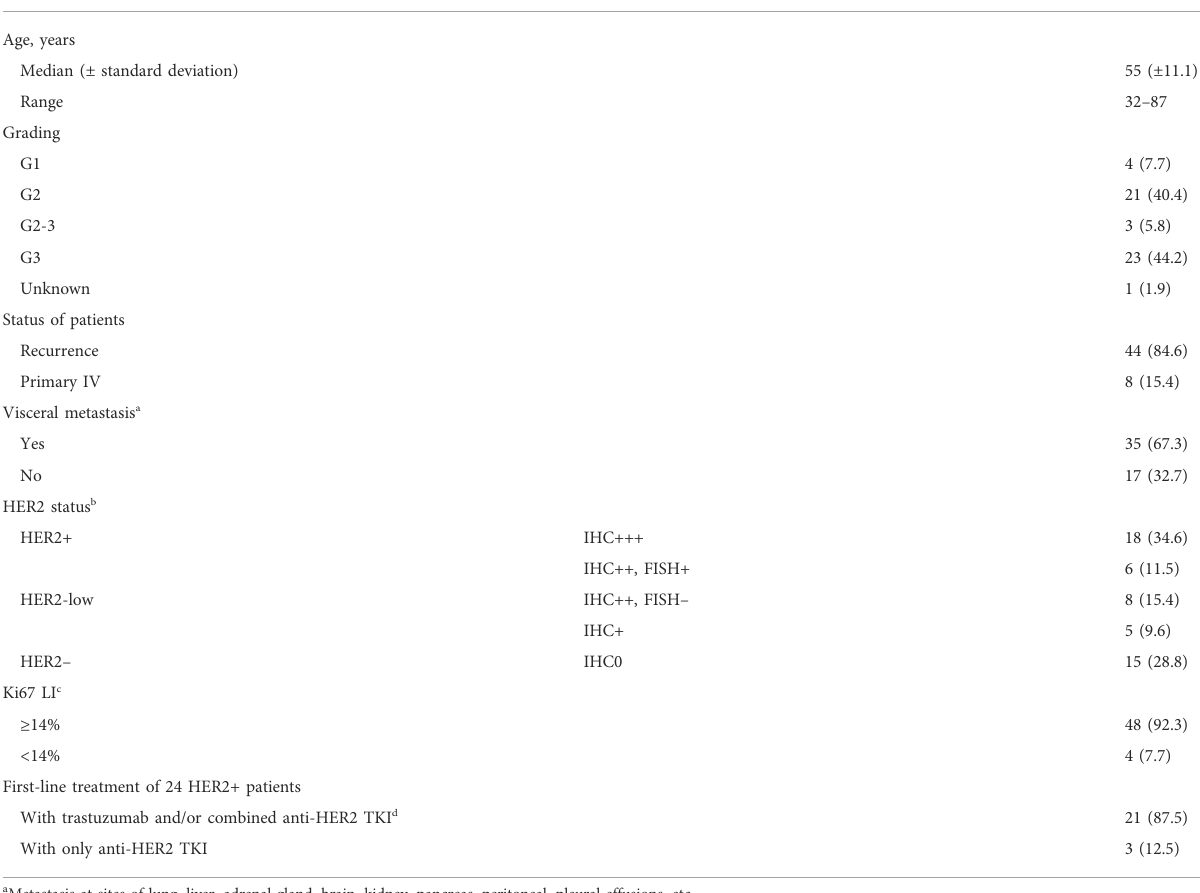
TABLE 1 Clinical characteristics of recruited breast cancer patients ( n = 52). Clinical